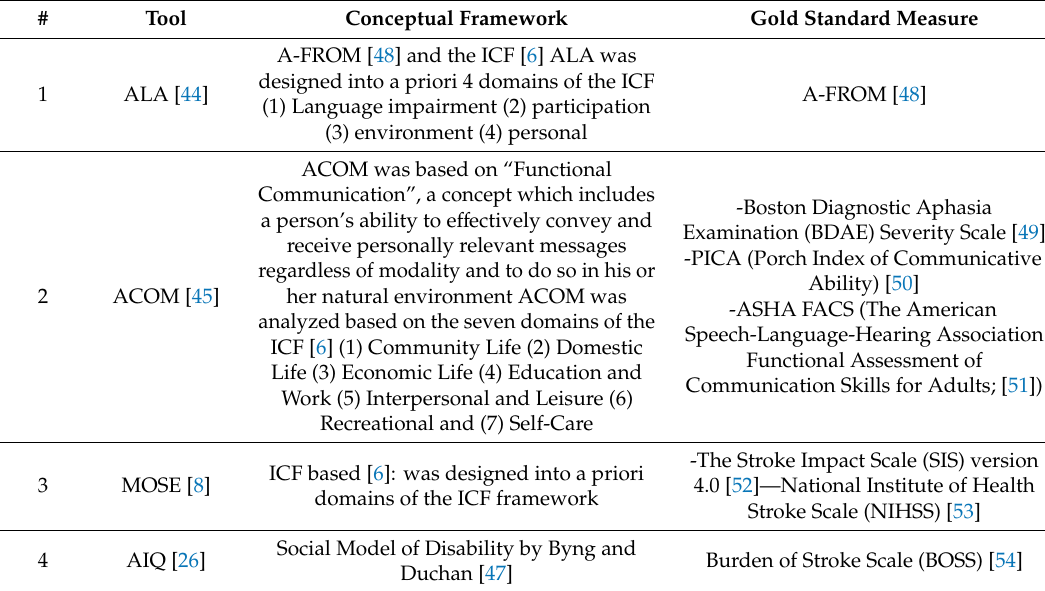
Table 2. Summary of the conceptual frameworks and gold standard tools of the four studies that included